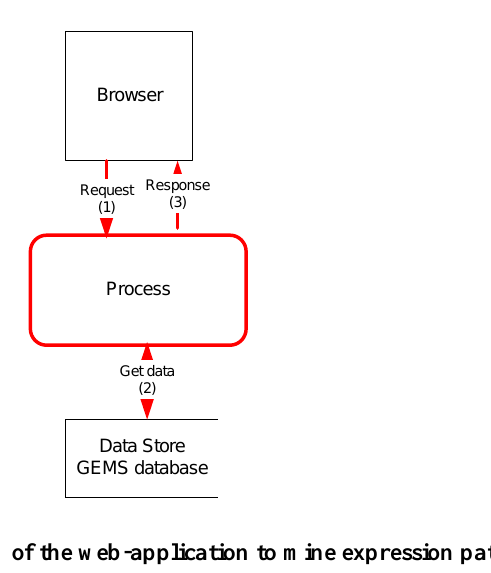
Figure 1: The process flow of the web-application to mine expression patterns.